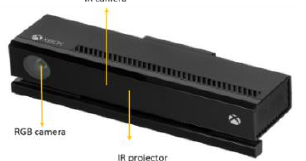
Figure 1. The Kinect v2 and the position of the imaging sensors and the IR projector